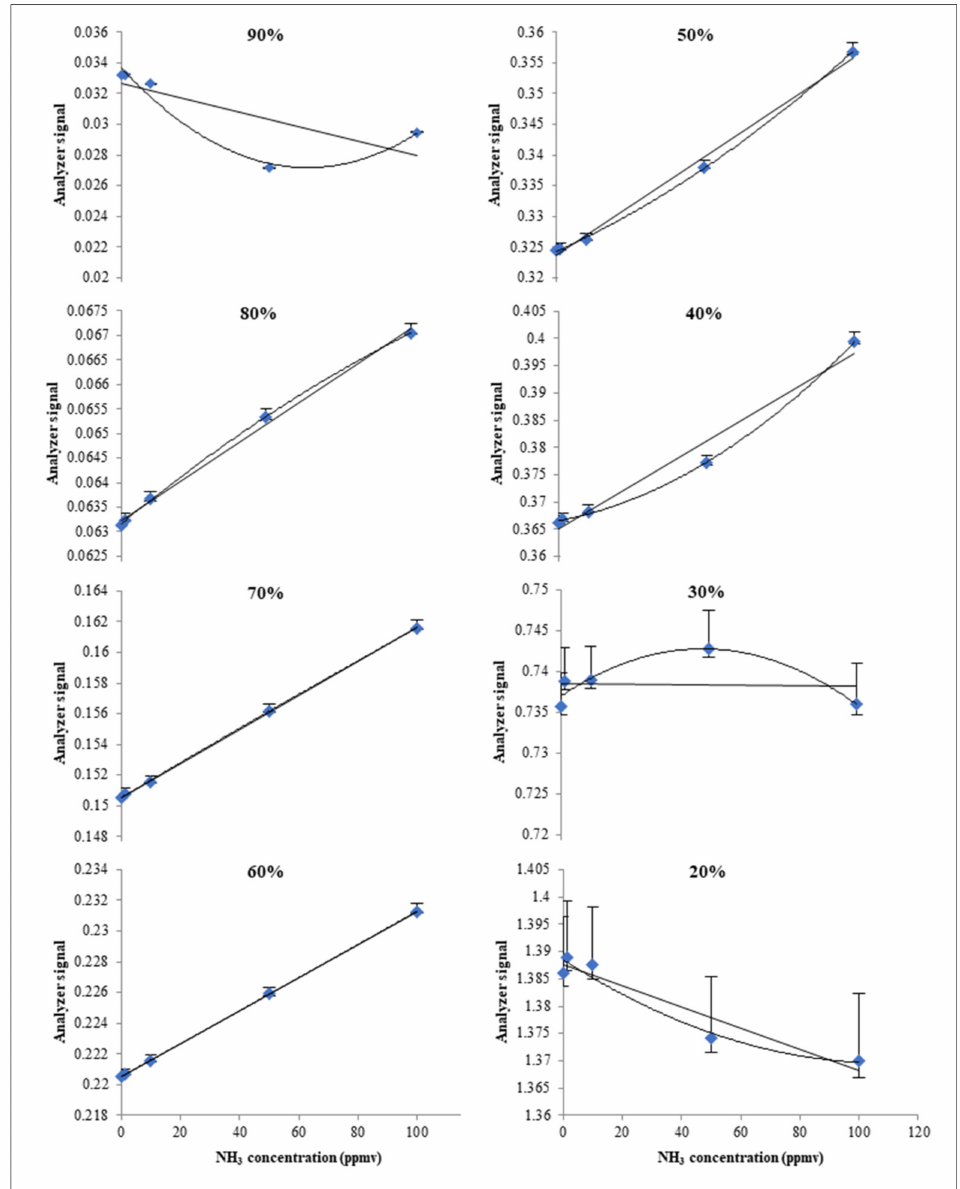
Figure 7. Relationship between analyzer signal and NH 3 concentrations associated with various beam reducers. (Error bars indicate min and max